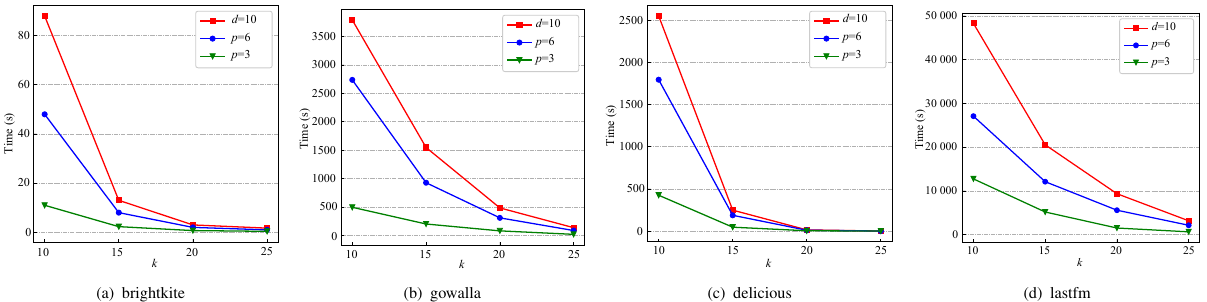
Fig. 2 Running time of MICS ( d DDD 10) and P-MICS ( p DDD 6 and p DDD 3).